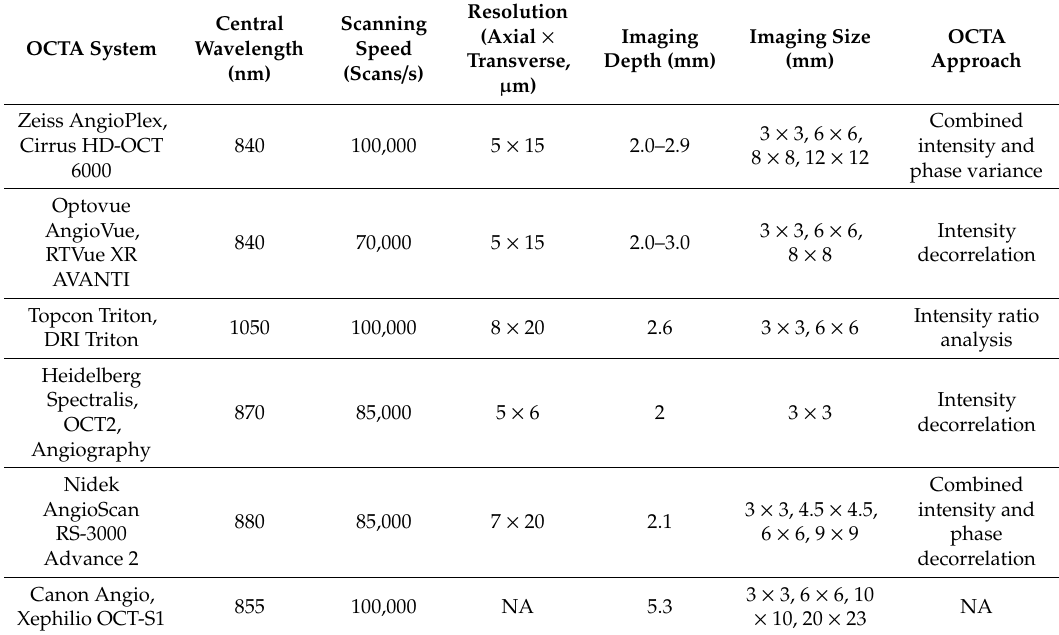
Table 1. Di ff erent main features provided by the manufacturer of the di ff erent OCTA